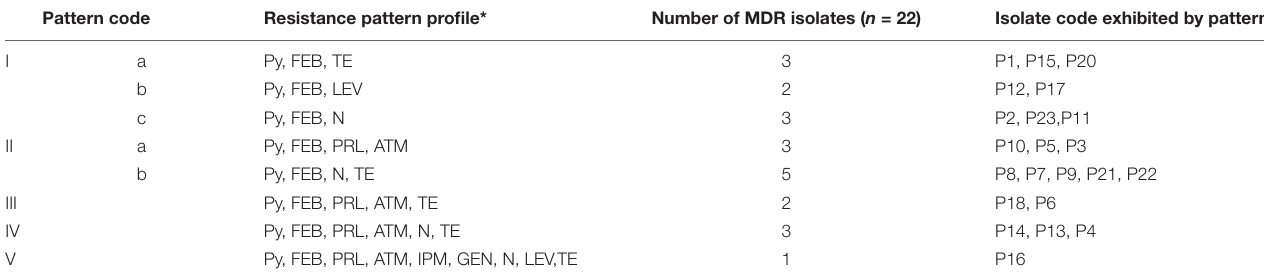
TABLE 1 | The antimicrobial resistance patterns of MDR P. aeruginosa isolates. Pattern code